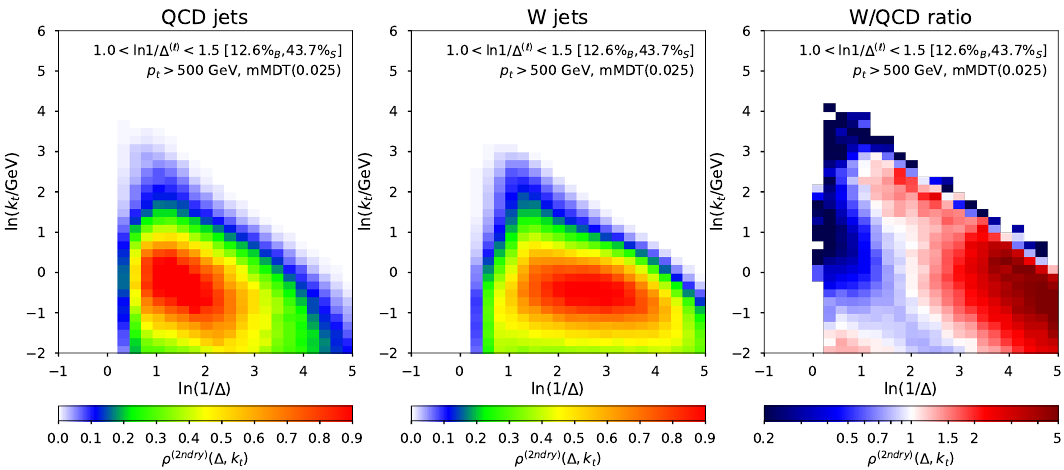
Figure 16. Averaged density, (cid:26) (2ndry) ((cid:1) ; k t ), of the secondary Lund plane associated with the leading (mMDT(0.025)) emission, for jets in which the leading emission’s angle satis(cid:12)ed 1 < ln 1 = (cid:1) ( ‘ ) < 1 : 5. From left to right: for jets in dijet events, for jets in WW events, and the ratio of the two. The percentages in square brackets indicate the fractions of jets for which the leading emission is in the given bin, for background and signal